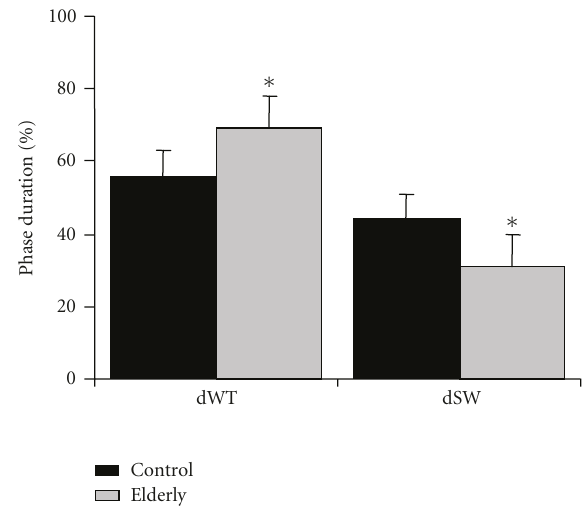
Figure 5: Temporal parameters during stepping up. dWT: relative weight-transfer phase duration, expressed as a percentage of to- tal movement duration; dSW: relative swing-phase duration. ∗ de- notes being significantly di ff erent from control subjects ( P < . 05).